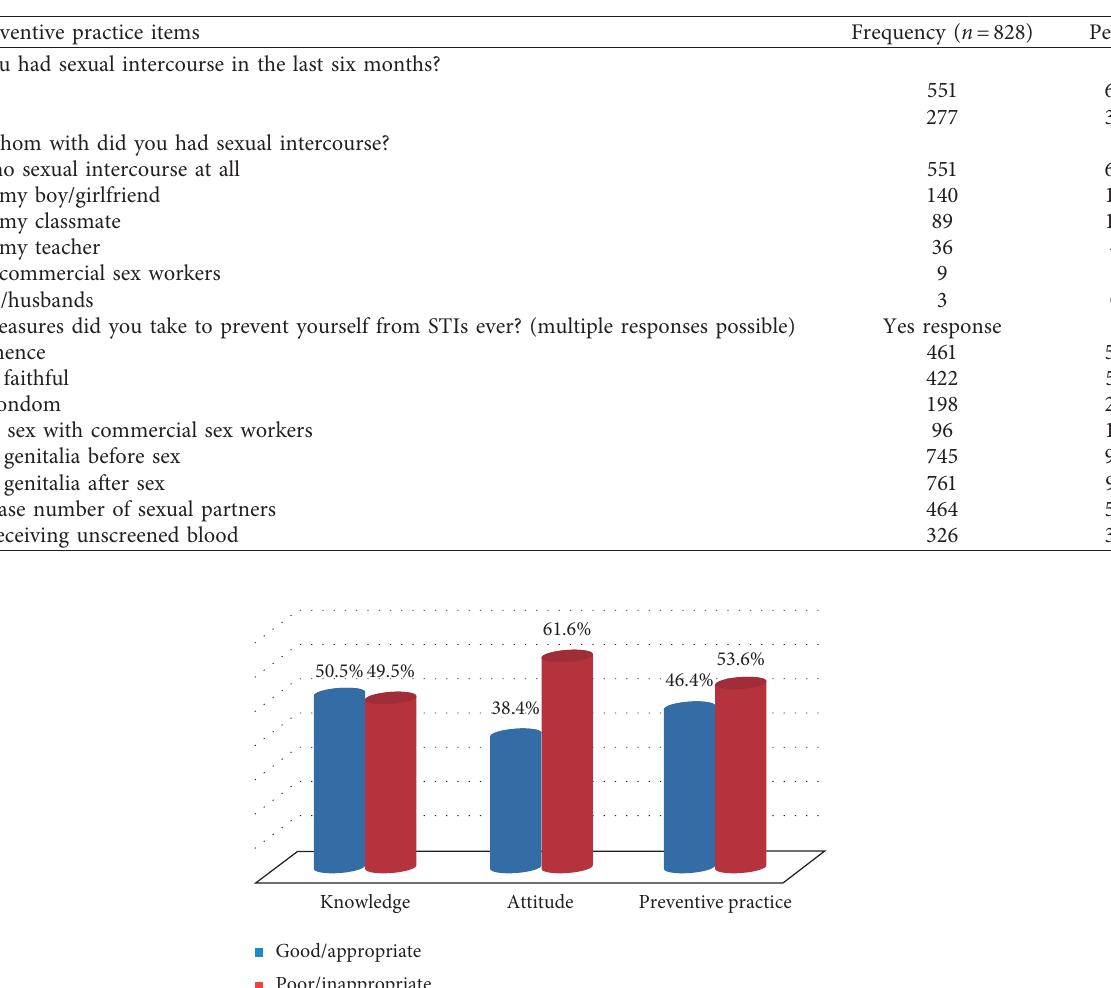
Table 4: Sexual practice and prevention practices for STIs among preparatory school students, West Gojjam zone, Northwest Ethiopia, 2018.